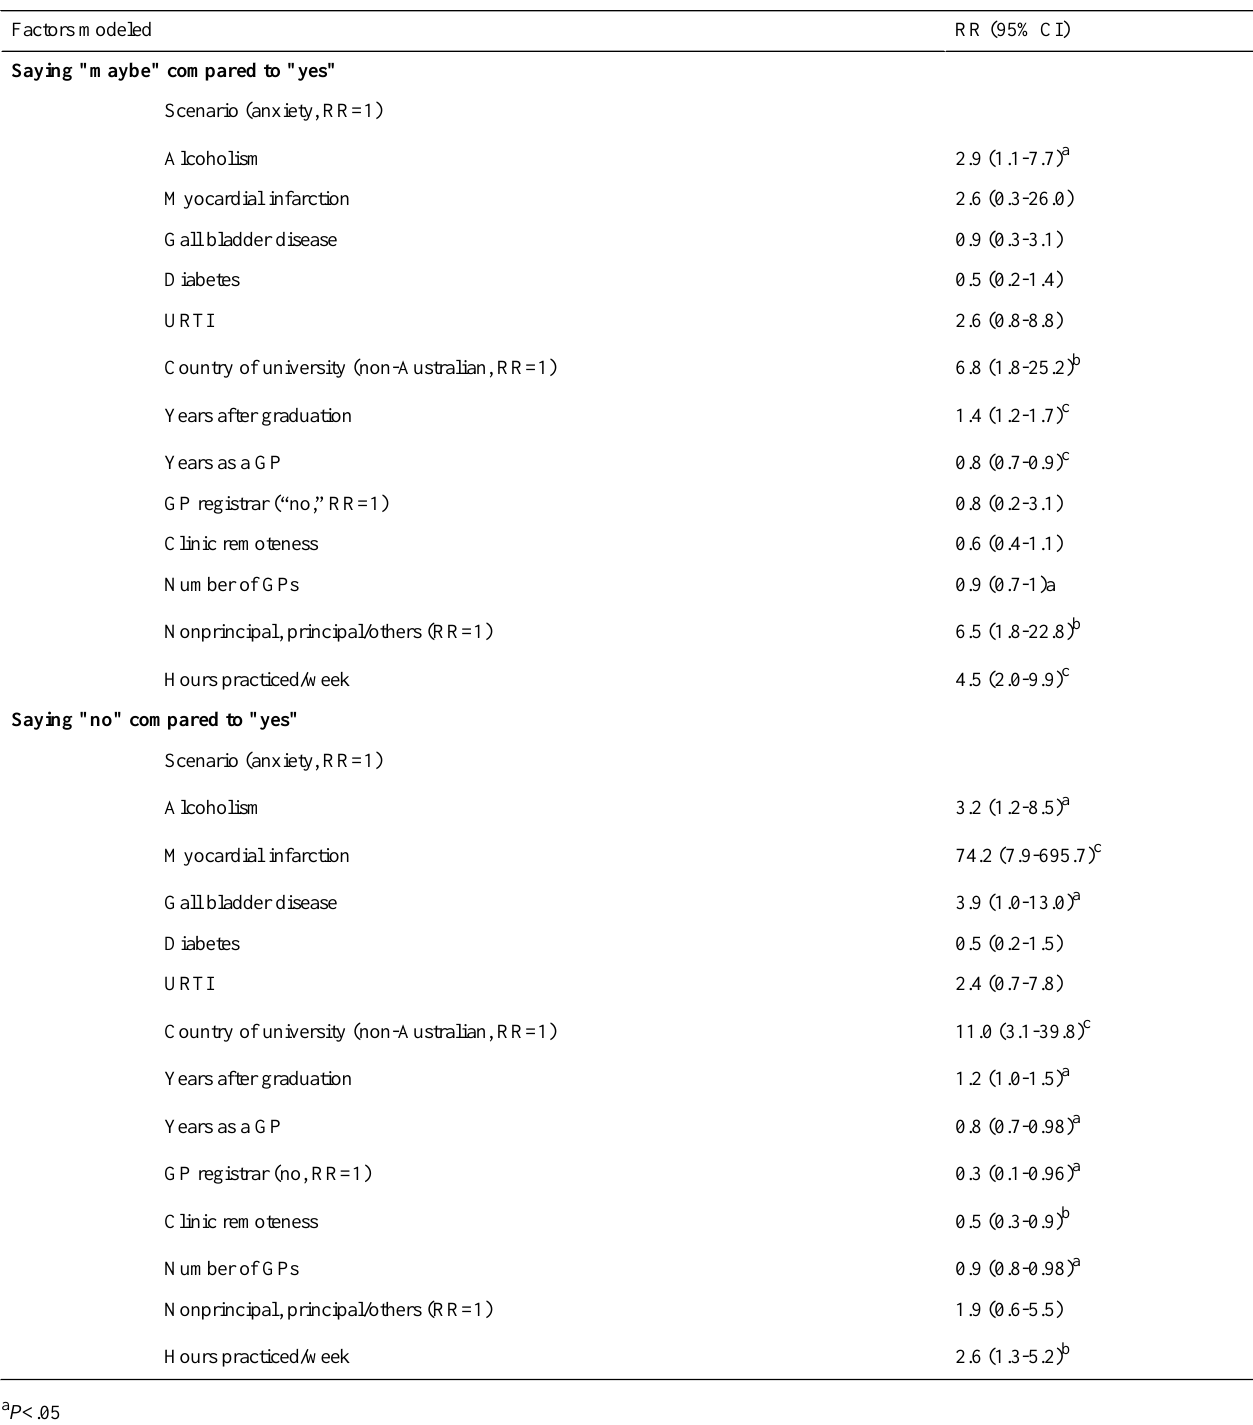
Table 8. Sociodemographic and scenarios as indicators associated with the intention to continue the consultation online.